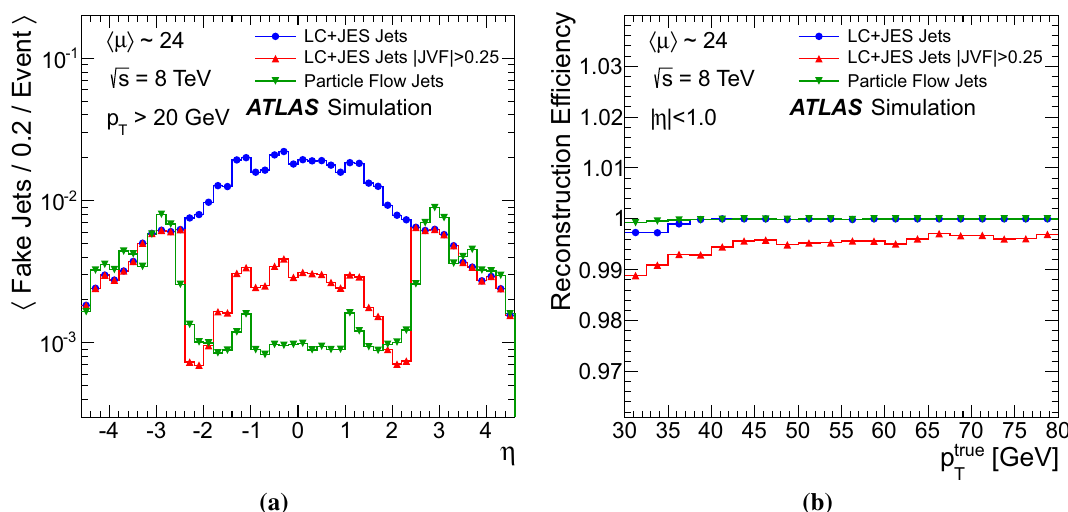
Fig. 29 In the presence of pile-up, ‘fake jets’ can arise from particles notproducedinthehard-scatterinteraction.Subfigure a showsthenum- ber of fake jets (jets not matched to truth jets with p T > 4GeV within (cid:8) R < 0 . 4) and b the efficiency of reconstructing a hard-scatter jet